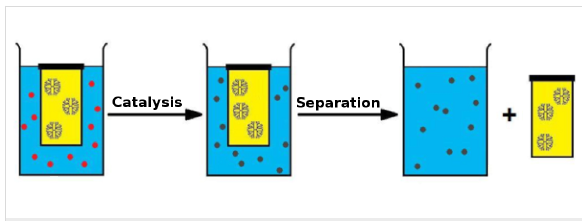
Figure 1: General approach for the use of dendritic catalysts in a dial- ysis